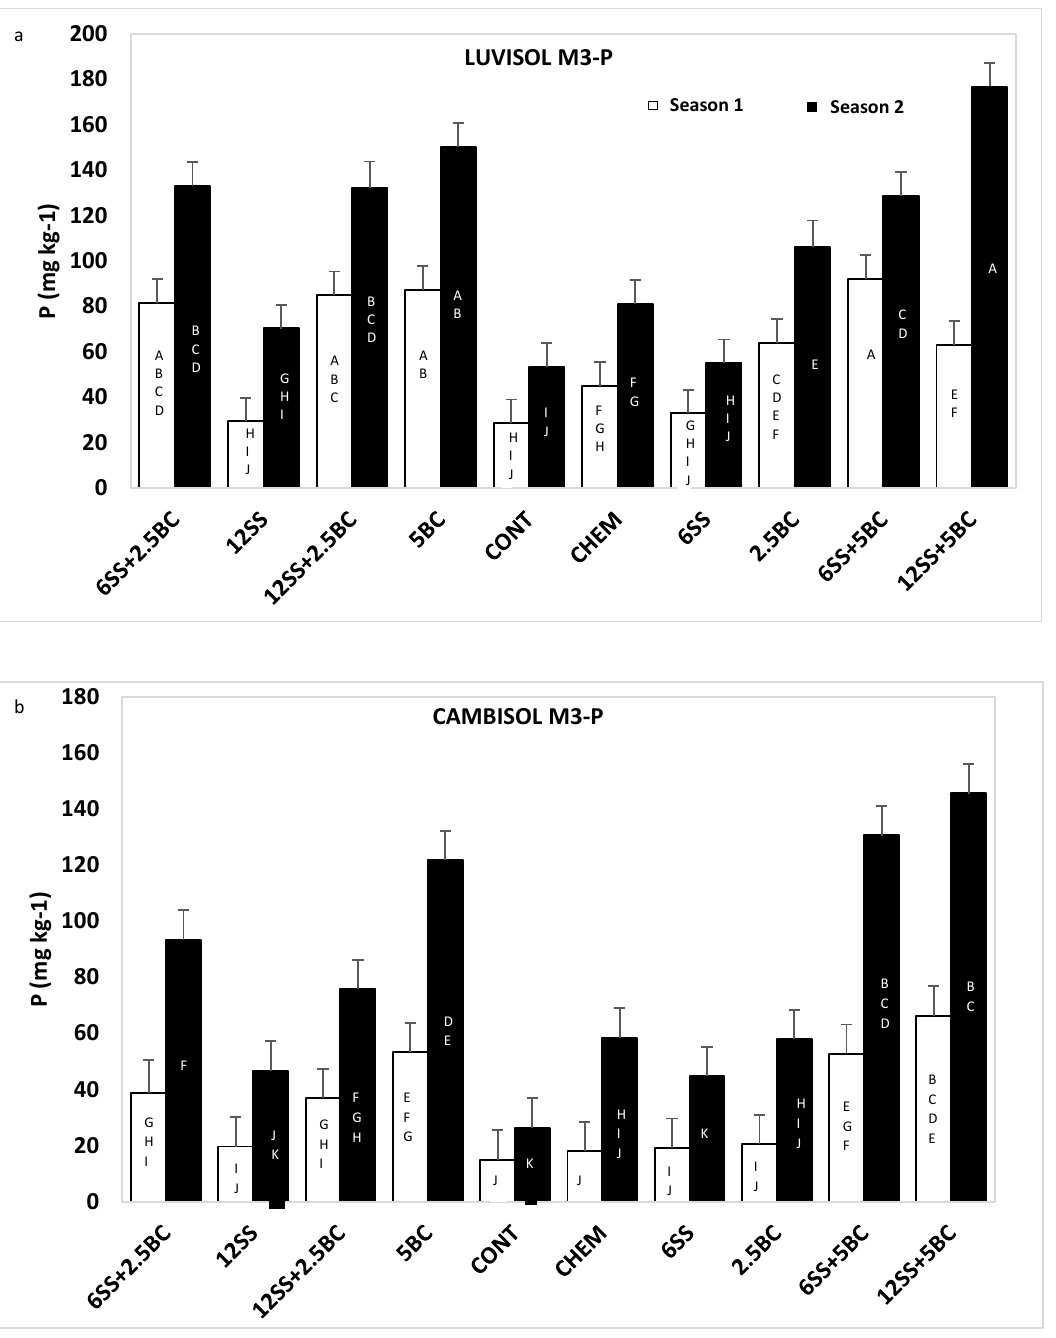
Fig. 3 M-3 P (a, b) and Plant leaf P concentrations (c, d) across of all treatments over the two seasons; March - April and July - Sep 2018 Error bars denote standard error of the mean (SEM). Columns with different letters are significantly different (p <